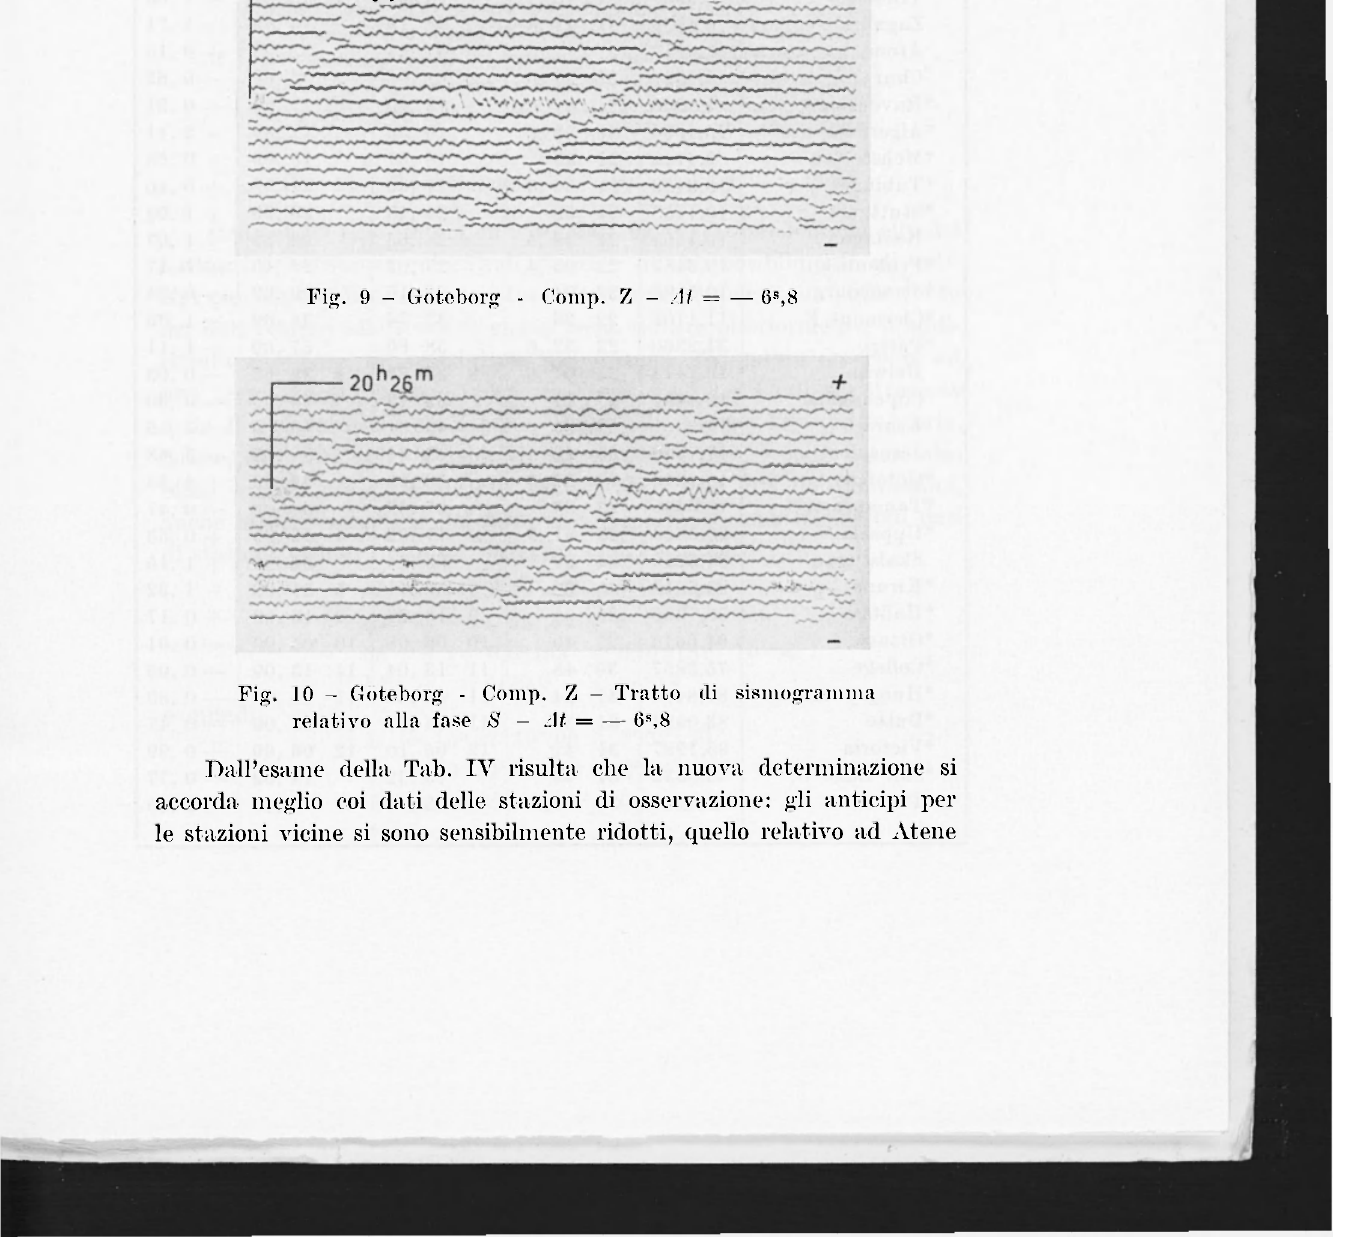
Fig. 9 - Goteborg - Comp. Z - zit = — 6 S ,8